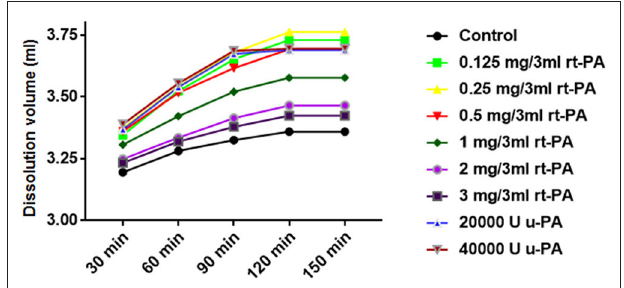
FIGURE 1 | Effect of time or concentration on the hemolytic efficiency of drugs. The 30, 60, and 90min dissolution curves of each group showed an upward trend ( P < 0.05), and the dissolution curves tended to be flat at 120 and 150min. The dissolution volume of 0.125 mg/3ml, 0.25 mg/3ml, 0.5 mg/3ml rt-PA, 20,000U, 40,000U u-PA was higher than that of 1 mg/3ml, 2 mg/3ml, 3 mg/3ml rt-PA volume ( P < 0.05).